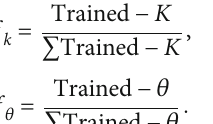
Figure 3: Reservoir con fi guration between water injection well and production well. Dynamic data re fl ect fl uid fl ow state (information characteristics) with di ff erent interlayer angles under di ff erent